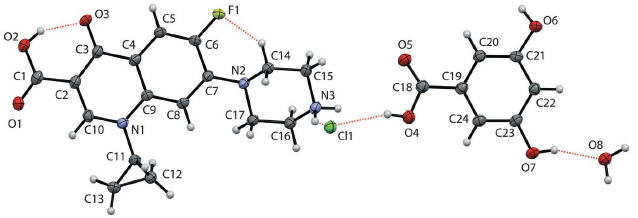
Figure 2 Displacement ellipsoid (50% probability level) drawing with the atomic labelling scheme for compound (II) showing the hydrogen bonds within the selected asymmetric unit.